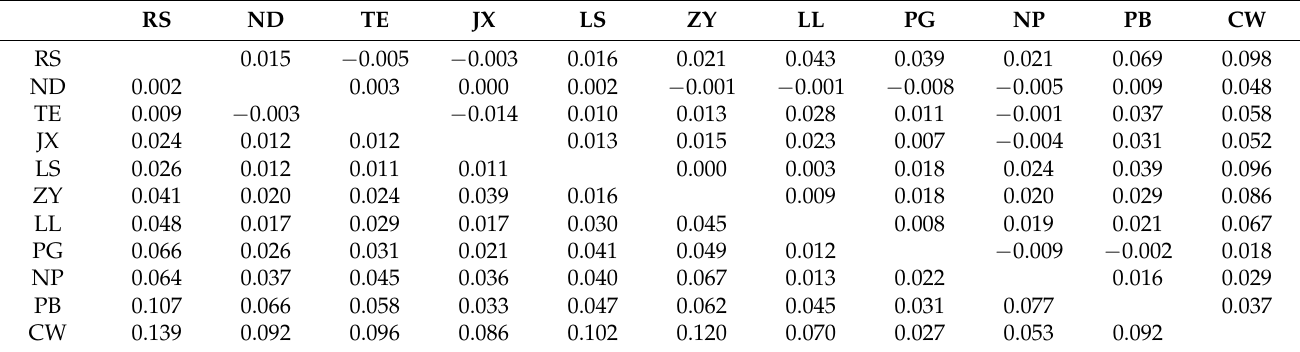
Table 7. Pairwise population differentiation based on Jost’s D and R ST values among 11 sampling localities on Chinese firs. Abbreviations for gene pools are given in Table 1. Pairwise Jost’s D values below diagonal; Pairwise R ST above